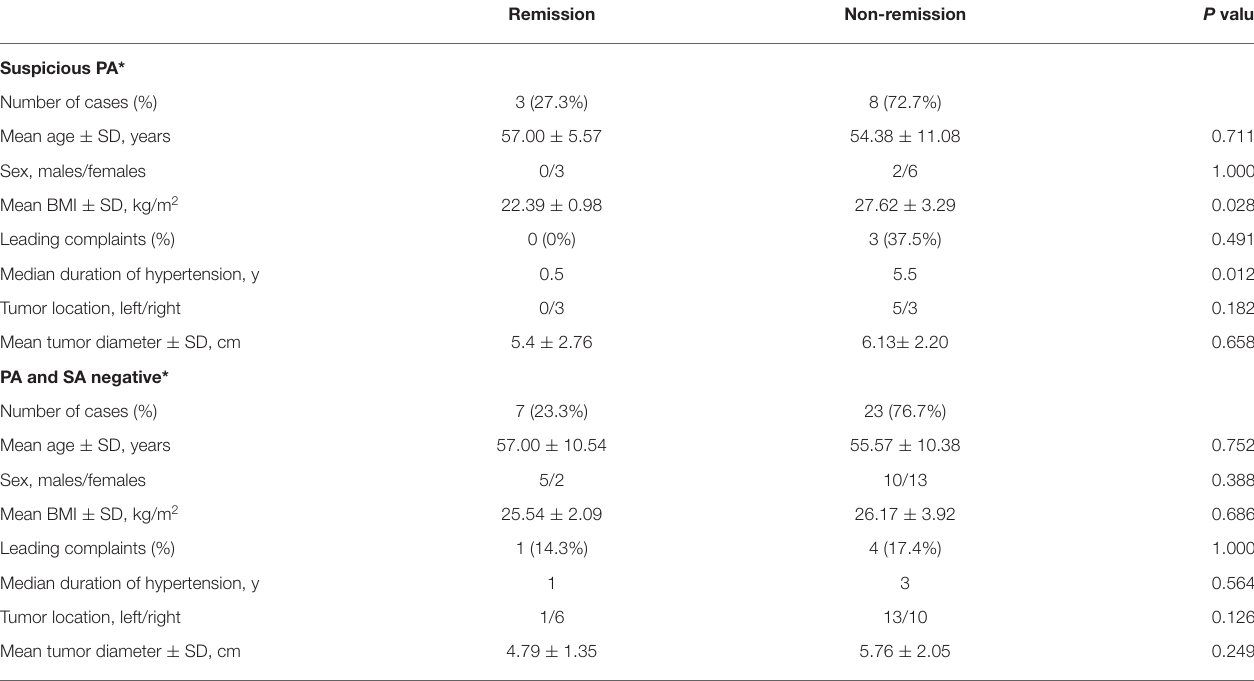
TABLE 3 | Characteristics of hypertension in 1 year after surgery according to preoperative PRA and